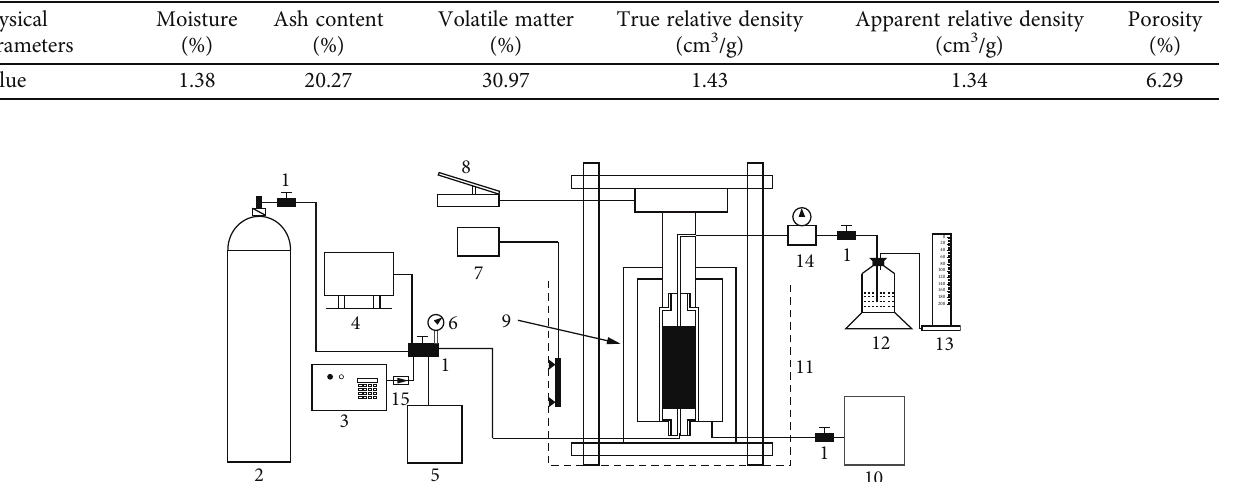
Figure 1: The two-phase displacement test device. 1: valve; 2: gas cylinder; 3: constant- fl ux pump; 4: vacuum pump; 5: gas storage tank; 6: pressure gauge; 7: temperature controller; 8: hydraulic oil pump; 9: adsorption tank; 10: hydraulic water pump; 11: water bath tub; 12: gas- liquid separation bottle; 13: gas collection cylinder; 14: pressure control valve; 15: one-way valve.